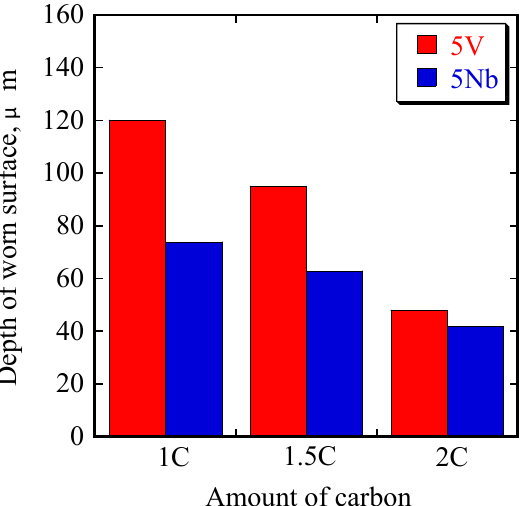
Figure 10. Depth values of worn surfaces of the two alloys with different C additions.